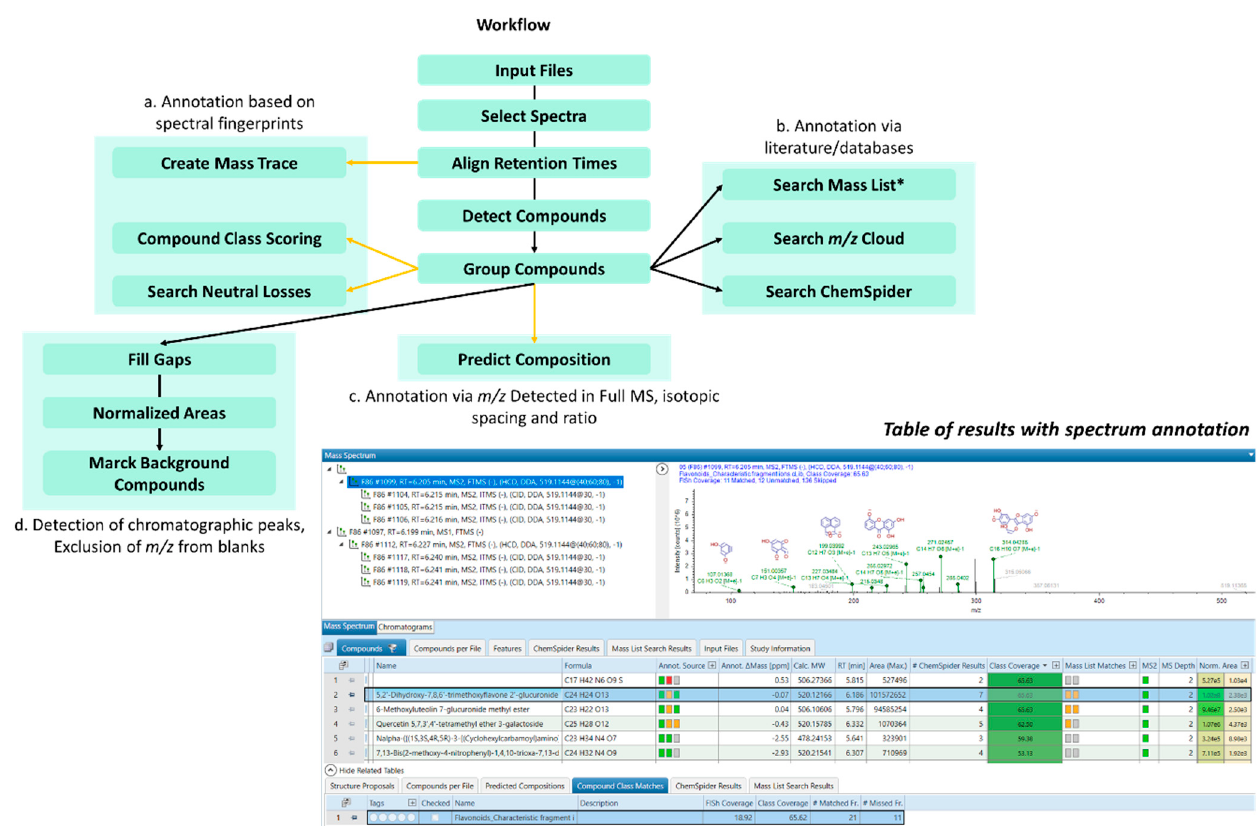
Figure 9. Flowchart for the untargeted workflow for the flavonoid annotation. The latter regroups different parameters, allowing for flavonoid profiling based on either their fragmentation patterns (a) or literature and databases (b). Formula was also given based on isotopic spacing and ratio (c). Search Mass List* includes all flavonoids with their exact masses, formula and structures provided from an in-house-created database containing 85 flavonoids, and the software included Arita Lab 6549 Flavonoid Structure Database . Normalized areas and Fill Gaps were used for the normalization of area chromatographic peaks and comparison of their retention times in different files for enhancing compound assignments in datasets. Mark Background was applied for exclusion of m/z values from the blank and the reduction in signal